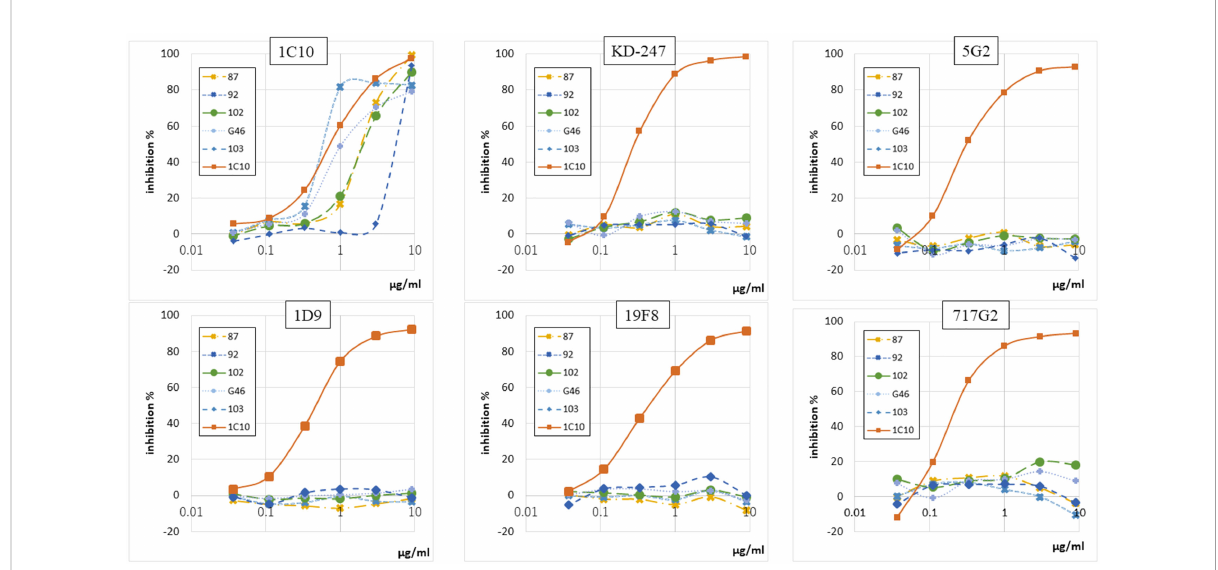
FIGURE 1 Five anti-Id abs inhibited only 1C10 among six anti-V3 abs. Binding-inhibition ability of fi ve anti-Id abs (87, 92, 102, G46, and 103), which interfere with interactions between anti-V3 abs and NNT-20, was determined by binding-inhibition ELISA using fi ve anti-V3 abs (1C10, KD-247, 5G2, 1D9, 19F8, 717G2) conjugated to biotin. Unconjugated 1C10 was used as a control binding inhibitor for all anti-V3